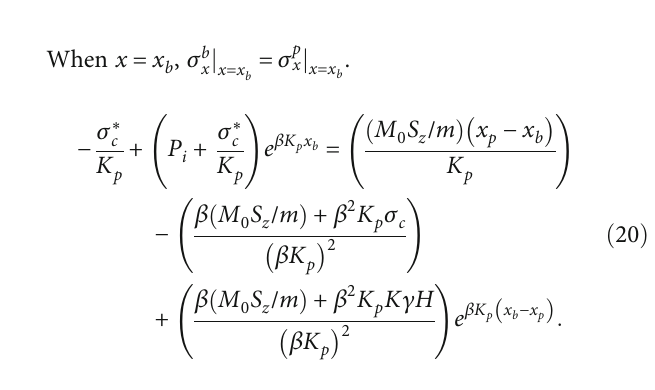
Figure 4: Coal wall spalling